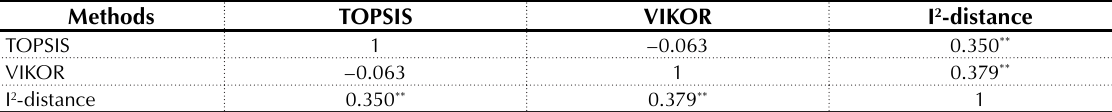
Table 10. Serial correlation coefficient between ranking methods